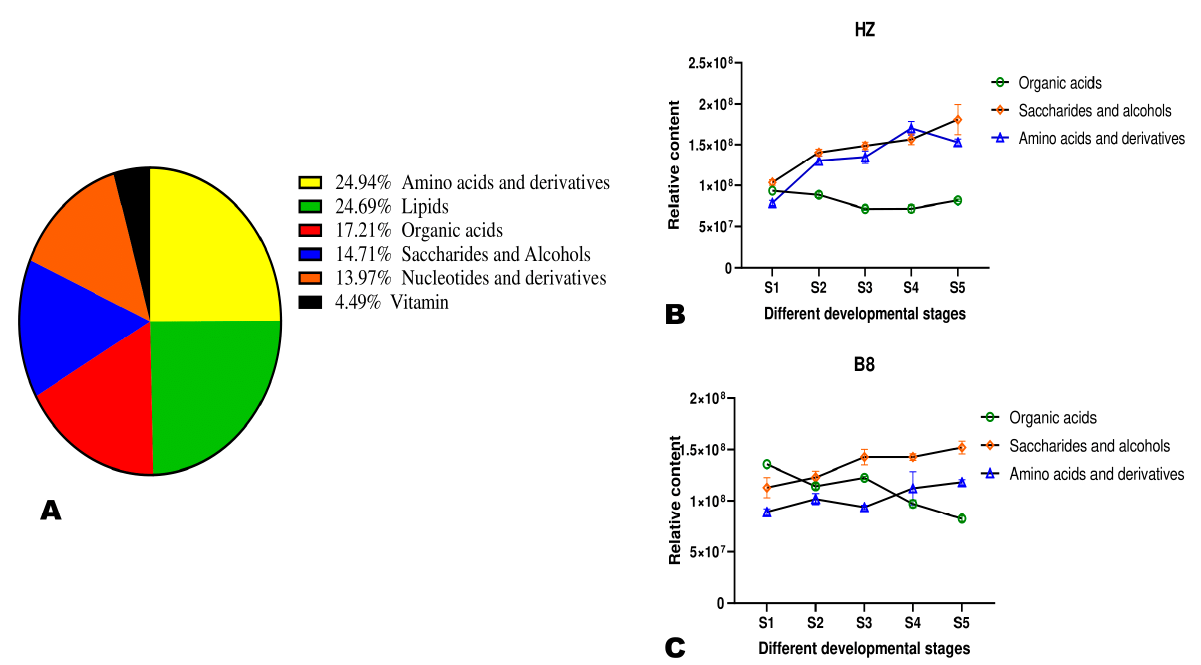
Figure 3. ( A ) Classification of the 401 identified metabolites in pulps of litchi fruit. ( B , C ) Dynamic changes in the total relative content of organic acids, saccharides and alcohols, and amino acids and derivatives in HZ and B8 pulps during fruit ripening, respectively.